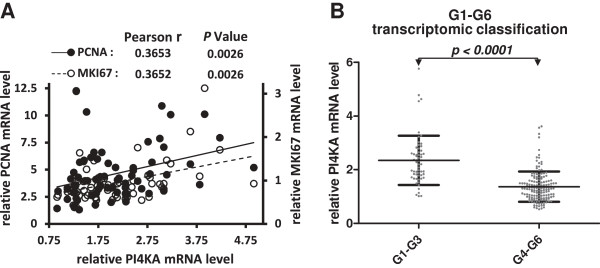
Correlation between PI4KA expression level, proliferative markers and molecular status of HCC. A correlation study between PI4KA expression levels and PCNA or MKI67 expression levels was performed in 60 HCC and 6 normal liver tissues analyzed with the HG-U133A Affymetrix GeneChip™ microarray. Pearson’s rank order coefficients and P values are indicated for the correlations (A). Scatter plots show the PI4KA mRNA as assayed by RT-real time PCR in HCC specimens stratified according to transcriptomic classification (G1-G3, n = 58; G4-G6, n = 149) (B). Values represent the gene expression of each sample relative to the mean value for two control samples from normal hepatic tissues. The 18S RNA levels were used for normalization. Means with standard deviations are indicated for each sample category. The P value from a Mann–Whitney U-test is indicated.